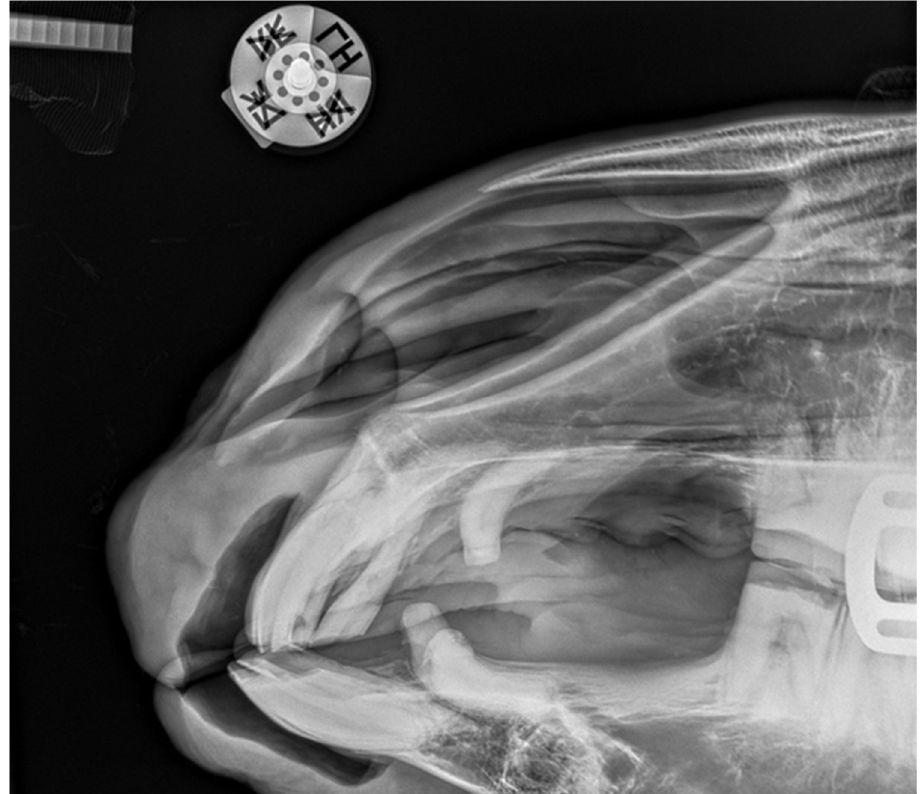
Figure 9. Case 2—lateral projection of the incisal area. Visible deformation of the incisal processes and osteomyelitis.